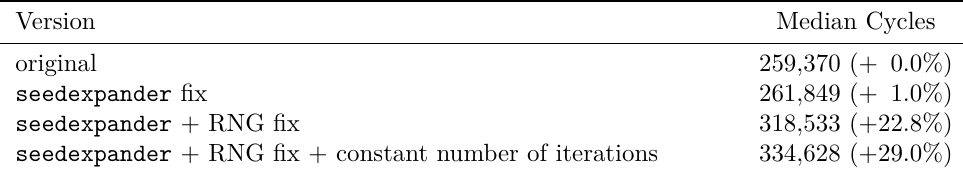
Table 7: Benchmark results in number of cycles for the modifications of the rejection sampling algorithm. Modifications tested on hqc-128. Cycle counts include the entirety of the decapsulation